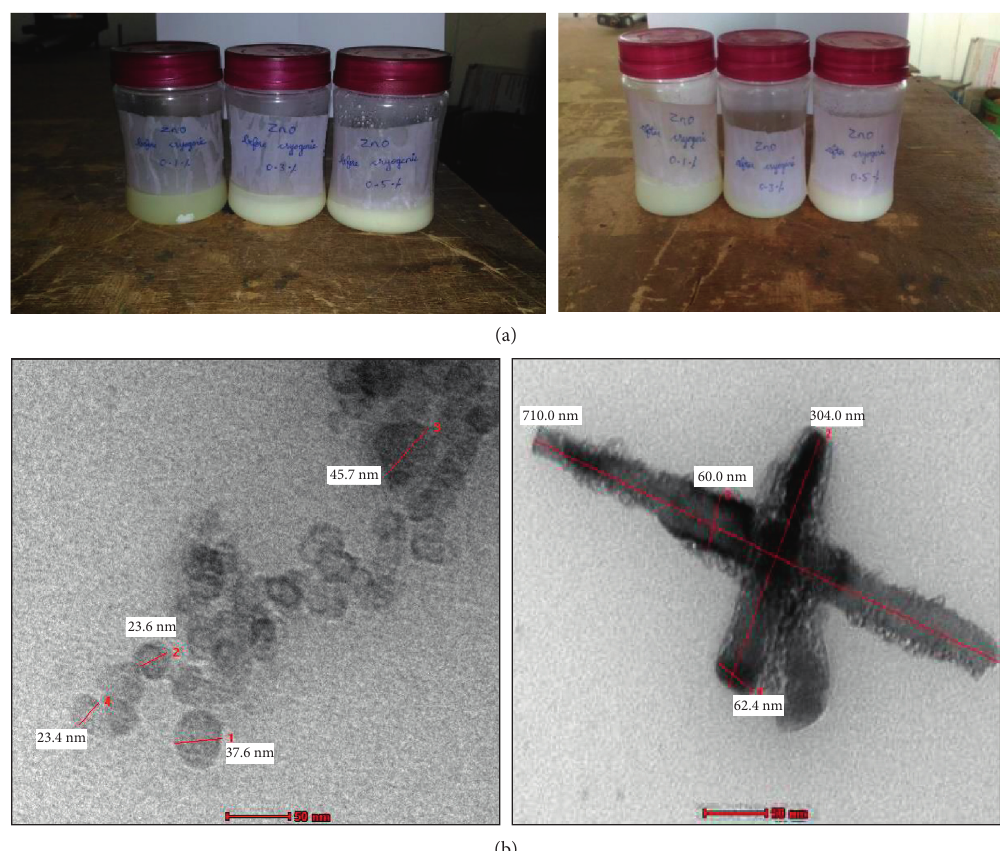
Figure 2: (a) Photographs of NPDP with (i) unmilled nanoparticles and (ii) ball-milled nanoparticles. (b) TEM images of NPDP mixed with oil: (i) ball-milled nanoparticles and (ii) unmilled